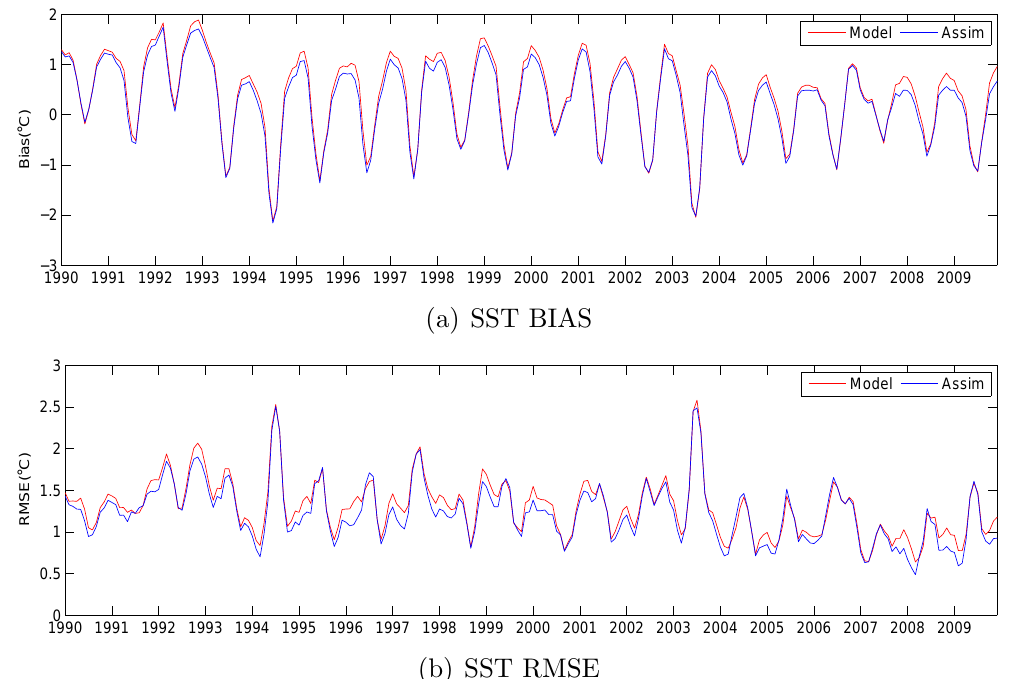
Fig. 3. The evolution of basin-averaged (a) bias and (b) RMSE calculated against monthly mean satellite SST from 1990 to 2009. Figure 3: The evolution of basin-averaged (a) bias (b) RMSE calculated against monthly mean satellite SST from 1990 to 2009. model are calculated by using bulk formulations. The